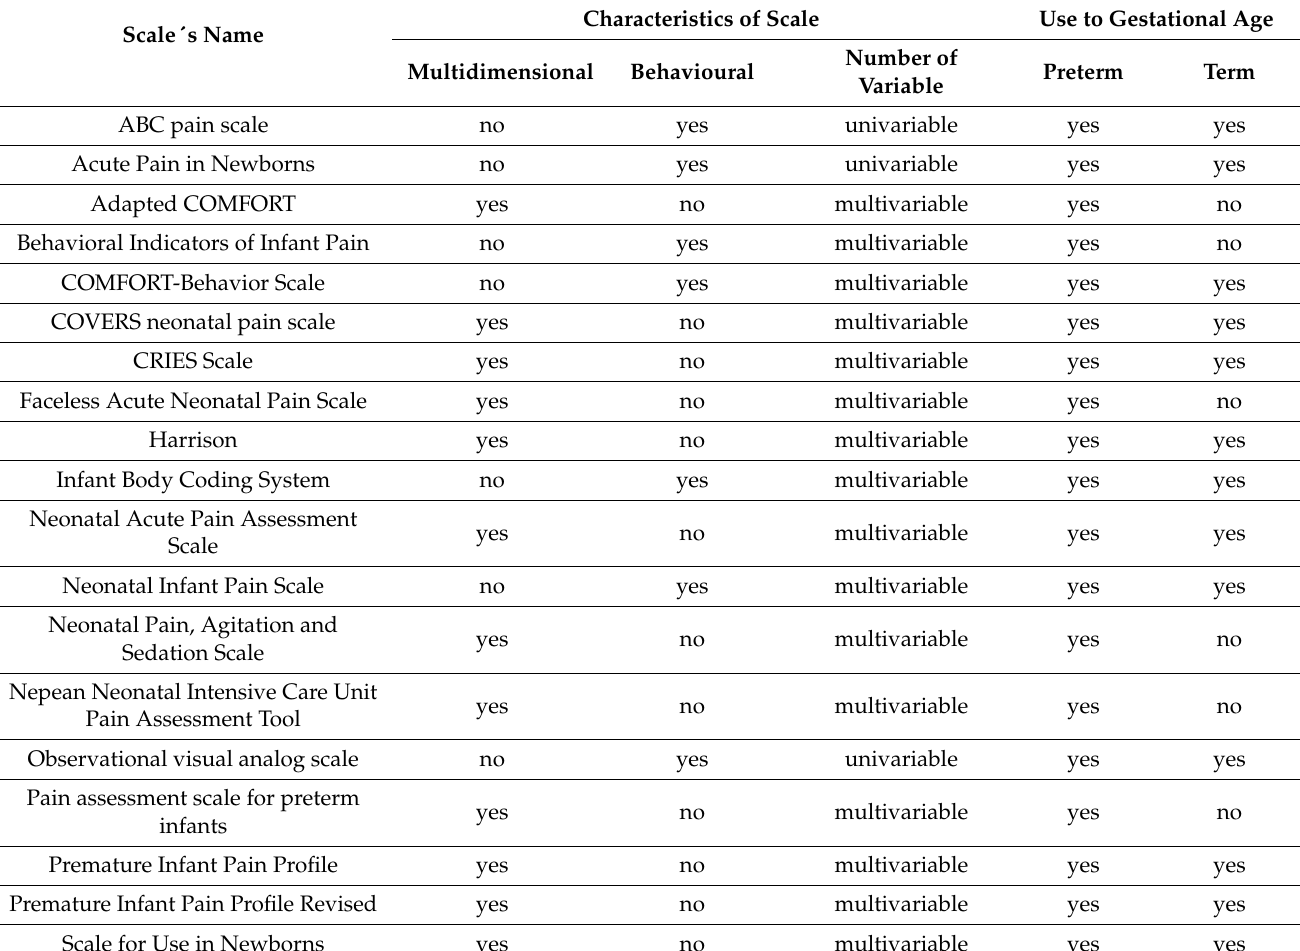
Table 1. Assessment scales for acute neonatal pain adapted from Giordano, V, 2019